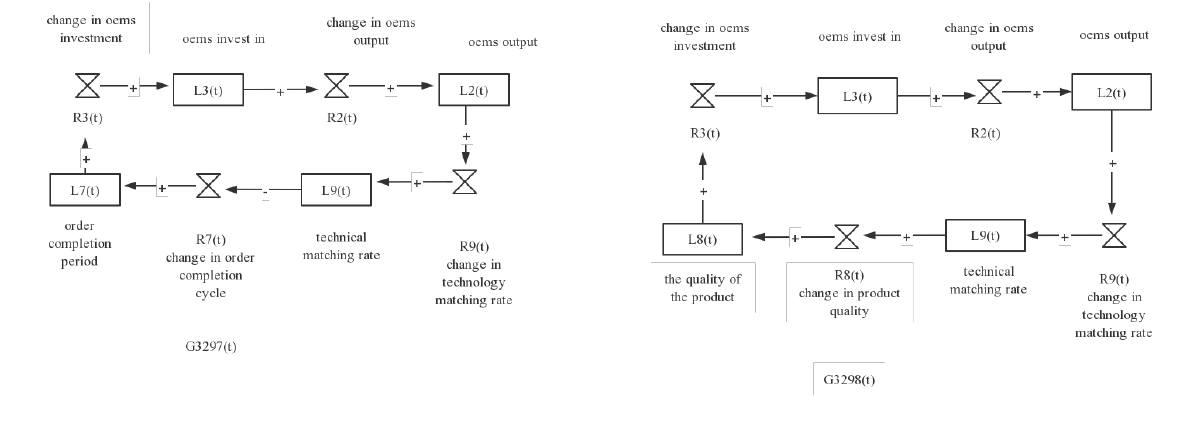
Fig. 2 OEMs performance